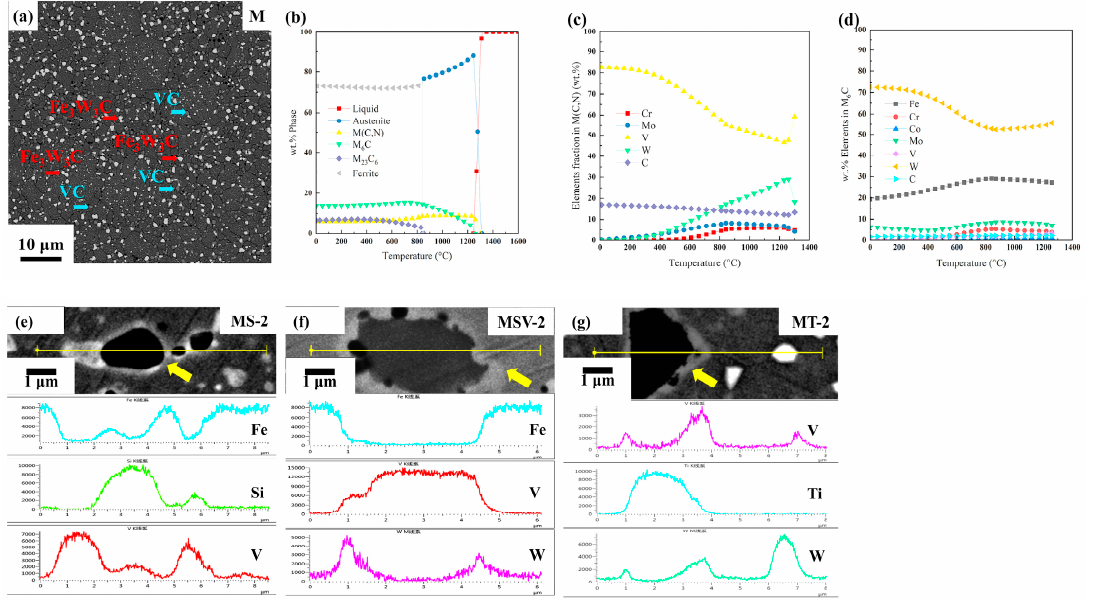
Figure 6. ( a ) The SEM backscattered electron (BSD) micrographs of the M sample, ( b ) calculated equilibrium phase diagram of S390 HSSs, ( c ) element variation in M (C, N), and ( d ) M 6 C predicted using JMatPro. The SEM-BSD micrographs and EDS results of S390 MMCs with different carbides: ( e ) MS-2; ( f ) MSV-2; ( g ) MT-2.